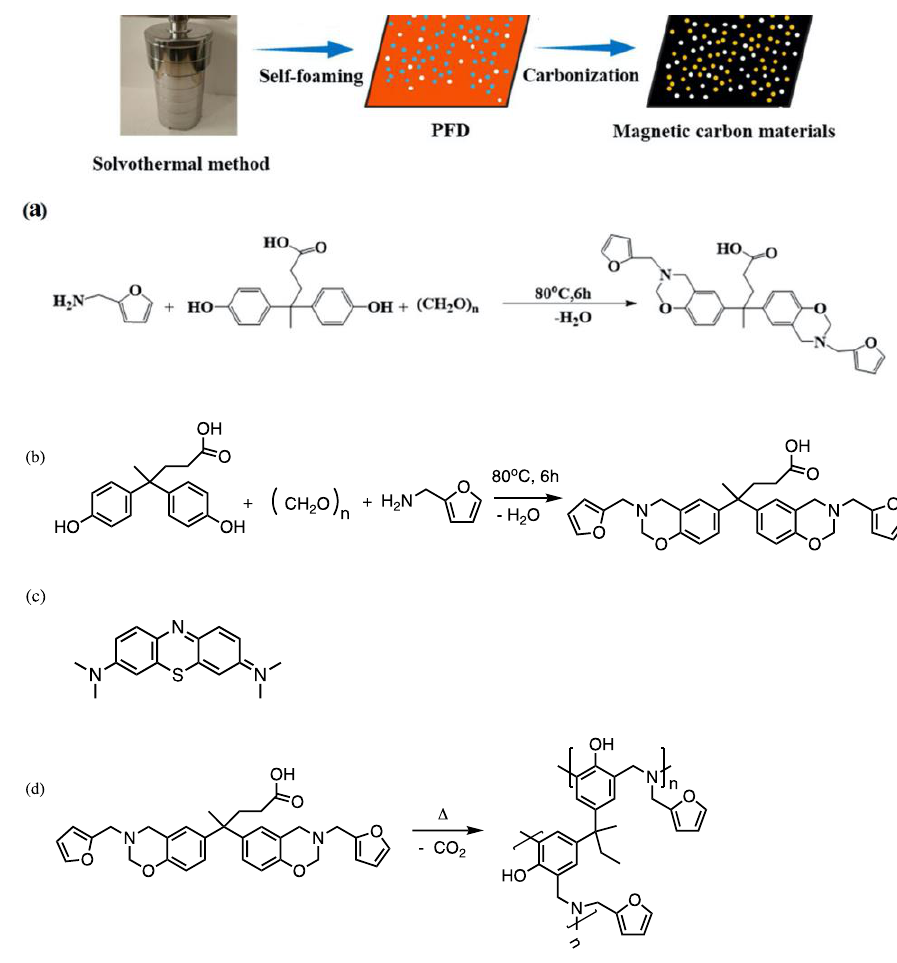
Figure 54. ( a ) Preparation process of novel biobased benzoxazine synthesized from DPA and furfurylamine with Fe 3 CO 4 nanoparticles dispersed prepared by the solvothermal method with simultaneous polymerization and self-foaming reactions of benzoxazine monomer and thermal decomposition of Fe(acac) 2 ; ( b ) Synthesis of the benzoxazine monomer; ( c ) the structure of the dye used, and ( d ) the polymerization scheme of the benzoxazine monomer. Only idealized structure is shown. (reproduced from the work in [124] with permission).